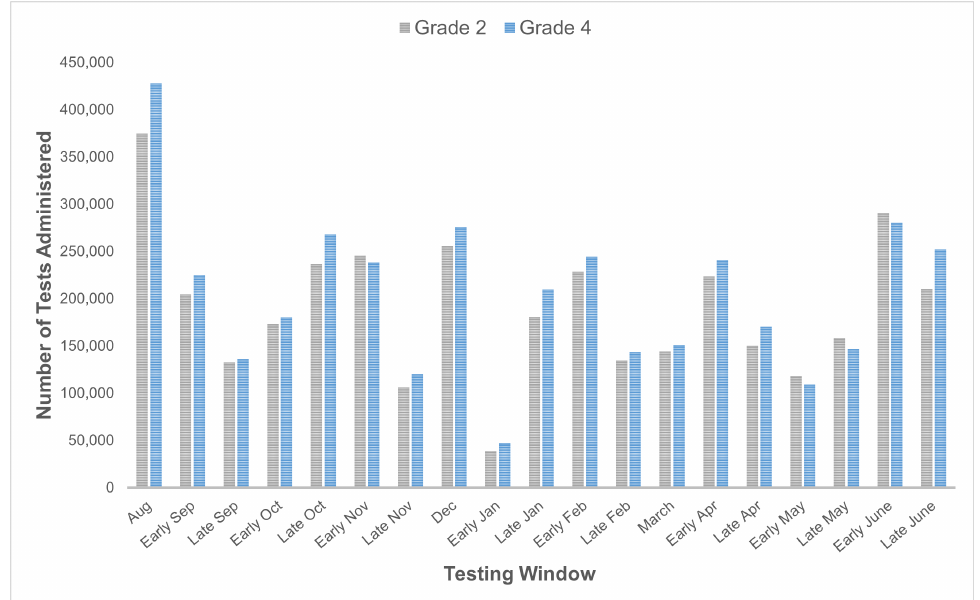
Figure 3. The total number of test administrations by testing